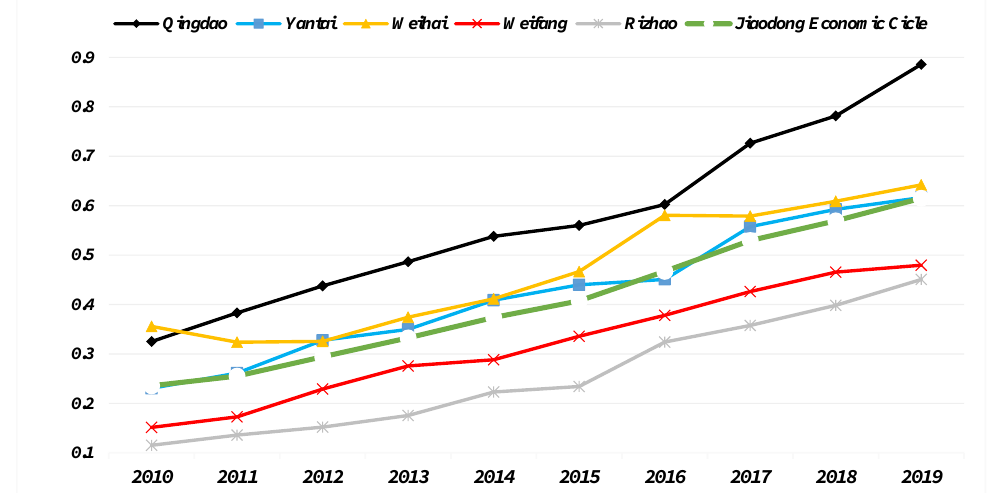
Figure 4. Timeseries of the comprehensive new-type urbanization level of 5 cities and the entire Jiaodong Economic Circle.